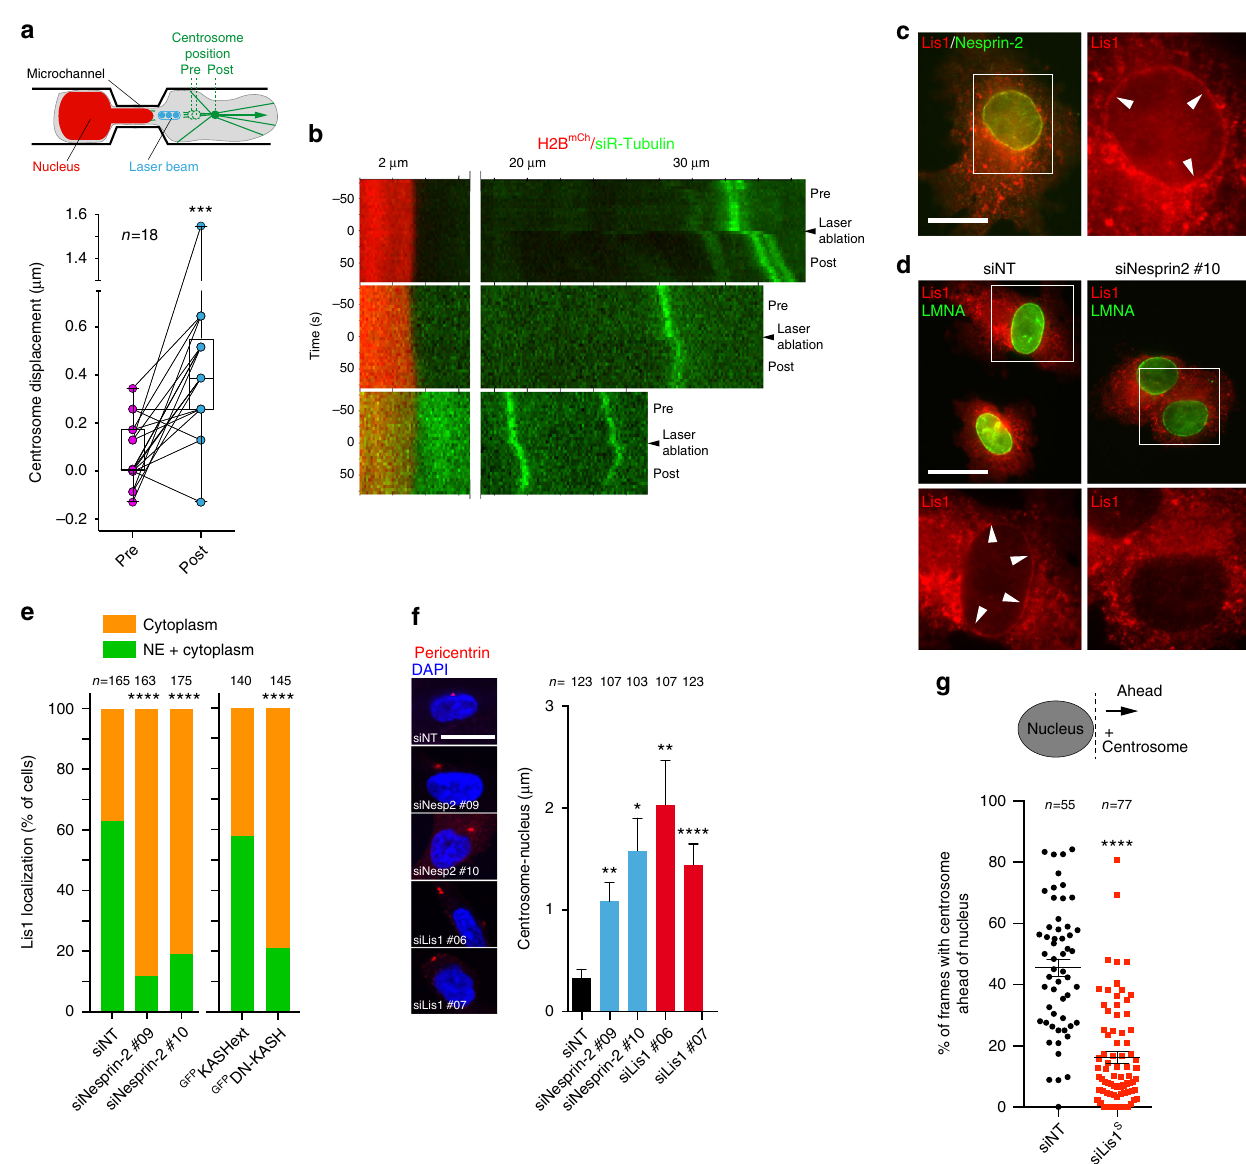
Fig. 4 Lis1 contributes to nucleus-centrosome linkage in MDA-MB-231 cells. a Schematic representation of MDA-MB-231 cell expressing H2B mCherry and with SiR-tubulin-labeled microtubules migrating through the microfabricated channel. Centrosome displacement was measured before (pre) and after (post) irradiation with the laser beam (blue dots) focused between the nucleus and the centrosome. Dashed green circles, positions of the centrosome before laser irradiation; green dot, centrosome position after irradiation. For each cell analyzed ( n = 18), the graph shows paired mean centrosome displacements (in μ m) before (pre) and after (post) irradiation; Wilcoxon signed rank test. b Kymographs showing elastic recoil of the centrosome after laser irradiation (time 0). H2B mCherry -labeled nucleus is shown in red, SiR-tubulin-labeled microtubules and the centrosome are in green. c Lis1 and Nesprin-2 immunostaining in MDA-MB-231 cells treated with nocodazole. d MDA-MB-231 cells treated or not with nesprin-2 siRNA were treated with nocodazole and immunostained for Lis1 and LMNA. Insets in c and d represent Lis1 signal of the boxed regions. Arrowheads point at regions of Lis1 association with the NE. e Percentage of cells with Lis1 association with the NE was scored in cells treated with indicated siRNA. n , number of cells analyzed from three independent experiments; Fisher exact test. f Pericentrin and DAPI immunostaining. Scale bars = 5 μ m. Mean centrosome-nucleus distance ( μ m) in MDA-MB-231 cells in 3D collagen under indicated conditions ± SEM; n , number of cells analyzed from three (siLis1 and siNesprin-2) or two (siLMNA) independent experiments; Kruskal – Wallis test. g Centrosome position related to the nucleus was scored as schematized from time-lapse sequences of MDA-MB-231 cells expressing GFP centrin-1 and H2B mCherry and treated with Lis1 siRNA or with control siNT during invasion through the small pore size collagen gel. The graph represents the percentage of frames with the centrosome ahead of the front edge of the nucleus for each cell analyzed and the corresponding Box-and-whisker plot. n , number of cells analyzed from three independent experiments; Mann- – Whitney test. * P < 0.05; ** P < 0.01; *** P < 0.001; **** P < 0.0001. Scale bars = 10 μ